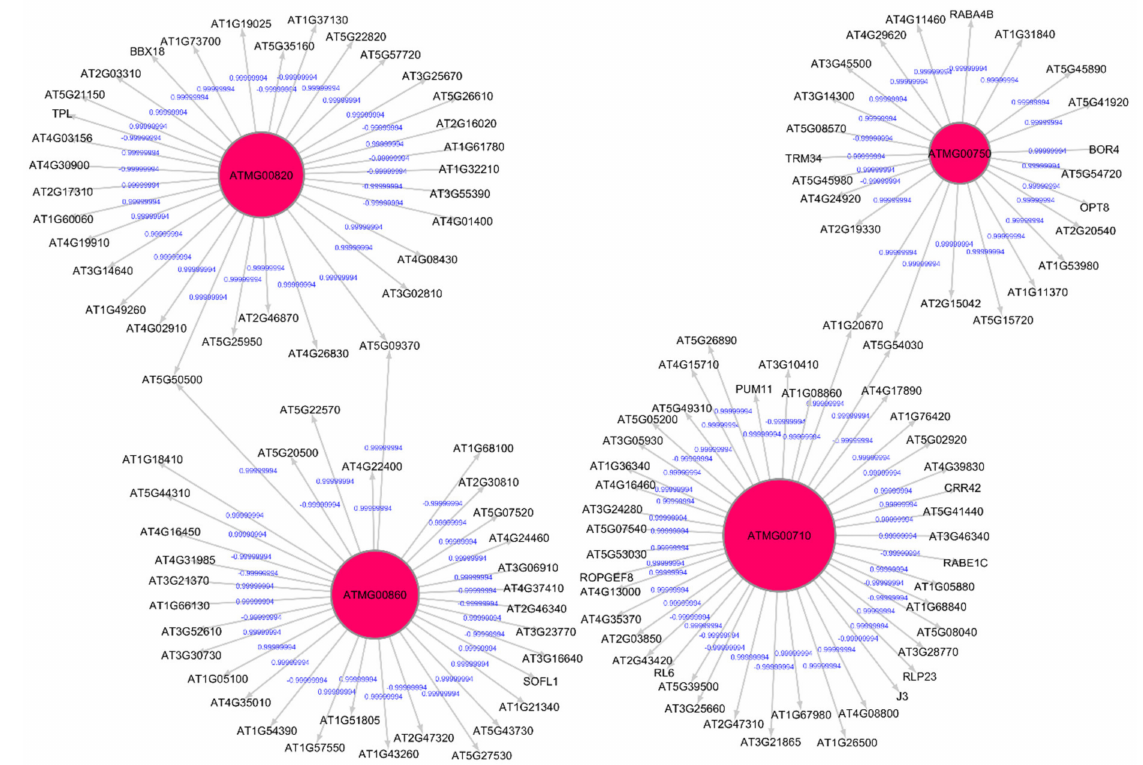
Figure 4. Gene regulatory sub-graph for Arabidopsis thaliana root growth in the ground control. The hub genes are the red circles representing the strong interactions with differentially expressed genes. The target (authority) genes are shown without circles. The weights on the arrows are the correlation values between the hub gene and the target